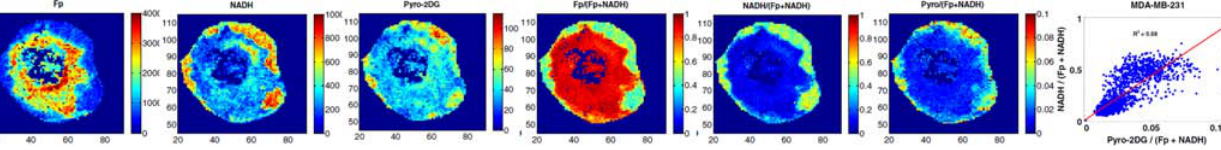
Fig. 6. The typical redox images of a MDA-MB-231 aggressive breast tumor section and the glucose (Pyro-2DG) uptake. After normalizing to Fp þ NADH to minimize the density variation, the glucose intake pattern is seen to positively correlate with the NADH redox ratio. The ¯gure is reproduced with permission from Ref.